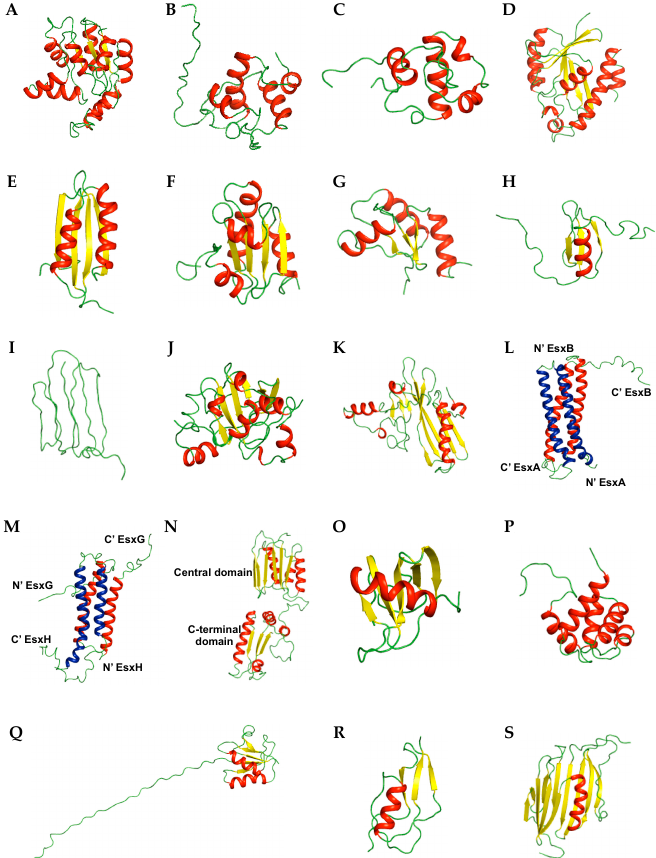
Figure 2. Ribbon representation of NMR structures of M . tuberculosis proteins. Enzymes and related proteins ( A ) Rv0733 (PDB ID 1P4S); ( B ) Rv1009 (PDB ID 1XSF); ( C ) Rv1884c (PDB ID 2N5Z); ( D ) Rv1014c